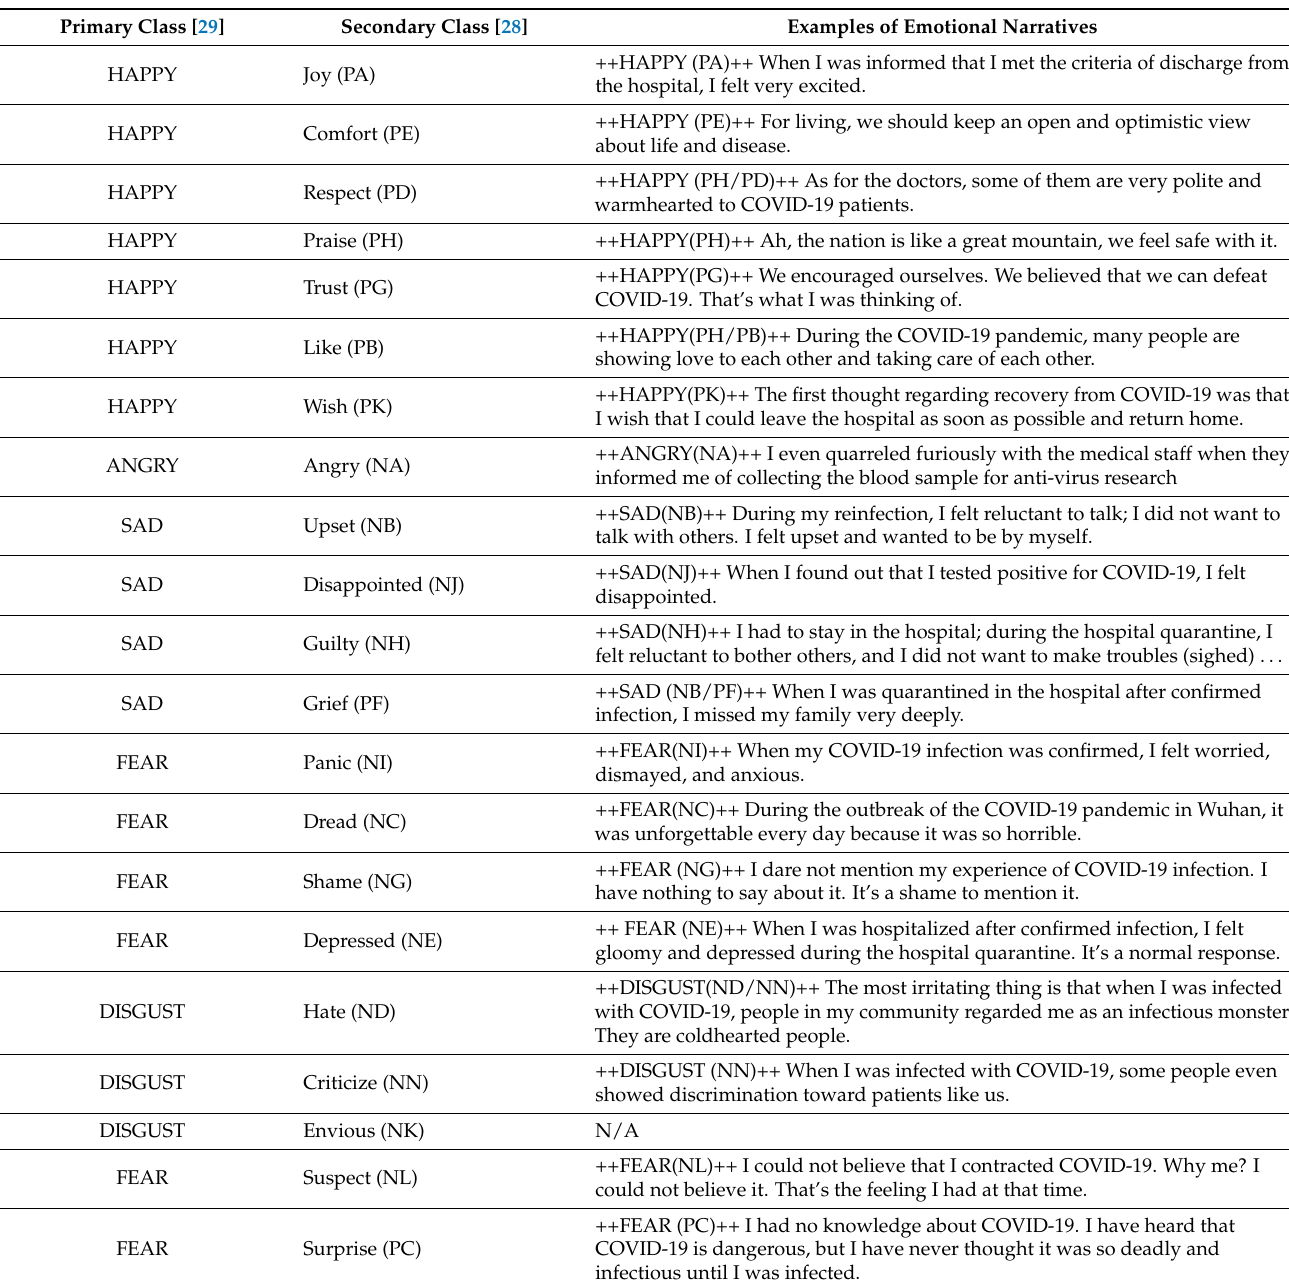
Table 3. Examples of emotional narrative